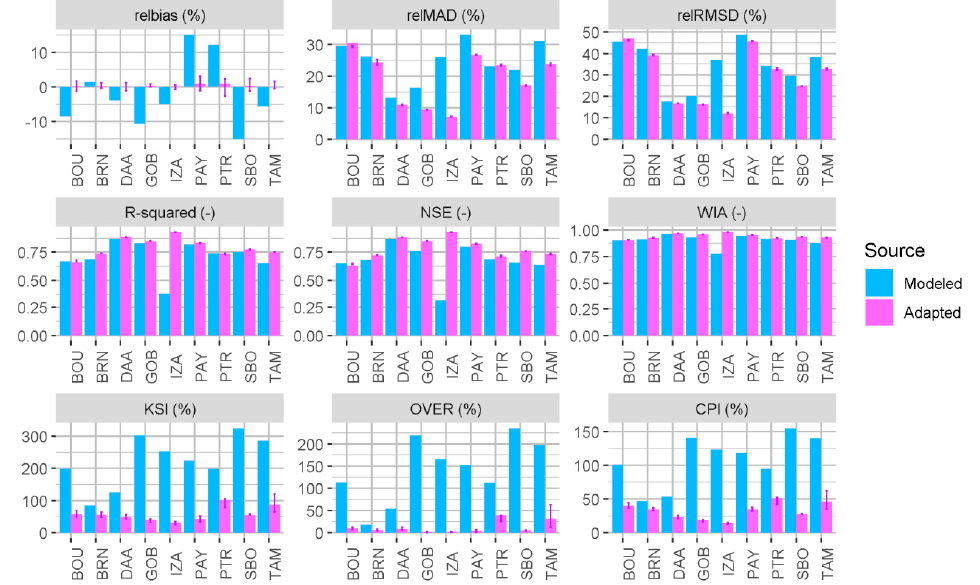
Figure 5. Statistical indicators of modeled and site-adapted DNI.